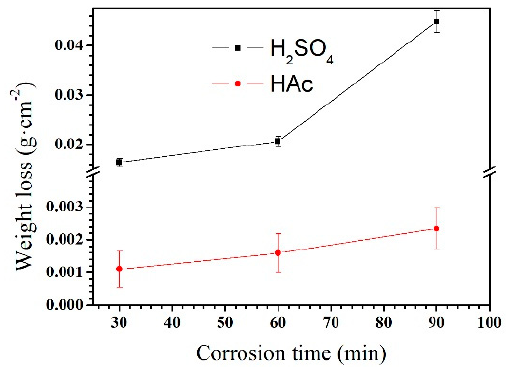
Figure 3. Weight losses of the Mg–Al alloy in H 2 SO 4 and HAc solutions for 30, 60, and 90 min.